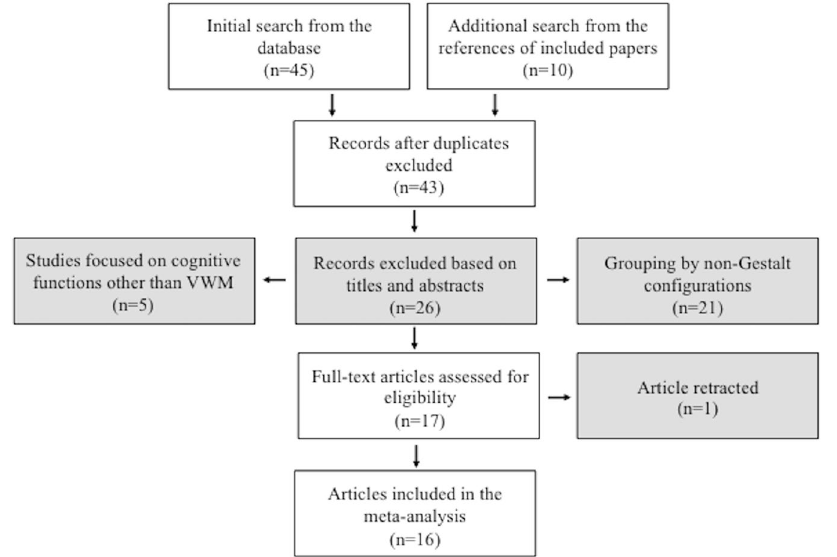
Figure 5. Flow chart of the process in literature